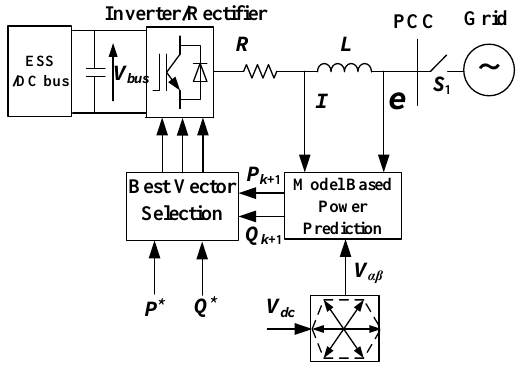
Figure 2. Block diagram of MPC-based power regulation.